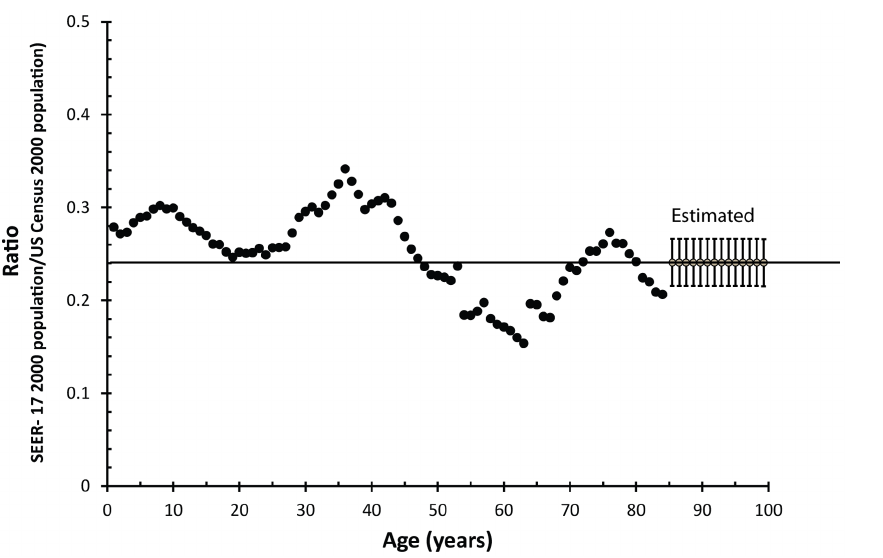
Figure 1. The ratio of the 2000 SEER-17 population to the 2000 US Census population is plotted as a function of age. To estimate the population by age of 85 to 99 year old people, we found the best match between the US population and the SEER-17 population for ages 60–84, indicated by the solid line at 0.24. We then used that multiplied that ratio (0.24) by the measured 2000 US Census population by age for 85 to 99 year olds, to obtain an estimate of the SEER-17 population by age for ages 85–99. This figure shows the estimates for ages 85–99, along with associated error and the ratio for ages 0–84 years of age.